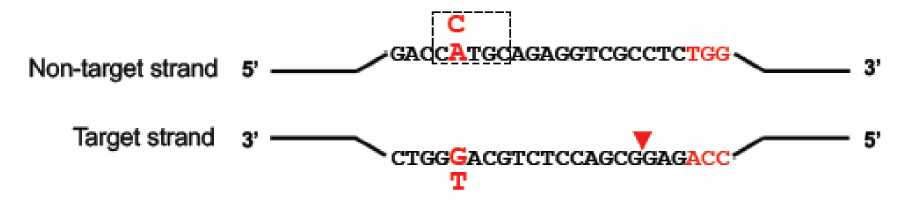
Figure 3. Schematic of base editing. Depending on the base editor used (CBE or ABE), cytosine (C, in blue) or adenine (A, in blue) in a ~5-nt editing window (dashed box) on the non-target strand can be deaminated and changed to a uracil or inosine (not represented), respectively. Nicking of the target strand by nCas9 in the base editor (red triangle) promotes DNA repair and incites the cell to use edited strand as a template. The uracil is then read as a thymine and the inosine as a guanine, converting a C-to-T or a